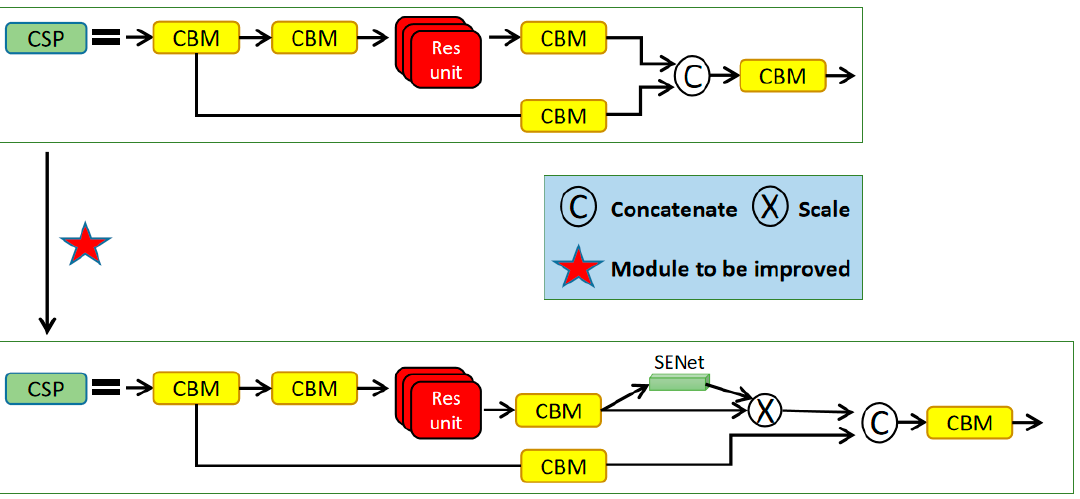
Figure 3. Improvement of the proposed method on backbone feature extraction network.